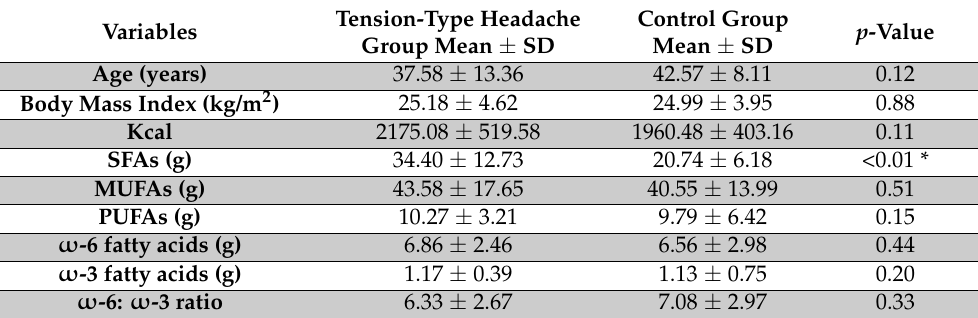
Table 1. Comparative analysis of daily intake of fats between tension-type headache group ( n = 24) and control group ( n =